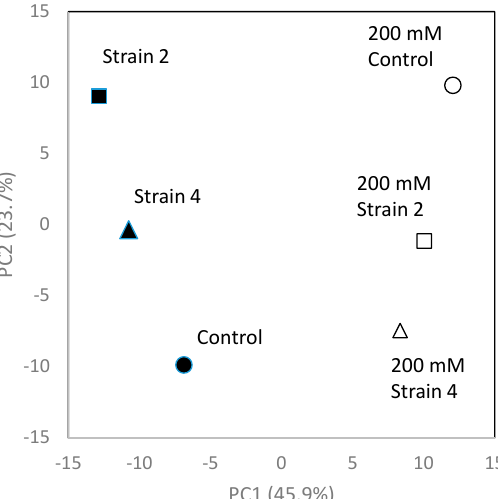
Figure 6. Scaling principal component analysis (PCA) based on metabolites detected in ice plants grown with/without NaCl and inoculation with strain 2 or strain 4 or mock inoculation. Open symbol and closed symbol indicate 200 mM and 0 mM NaCl, respectively. All samples and annotated metabolites were included in the PCA.